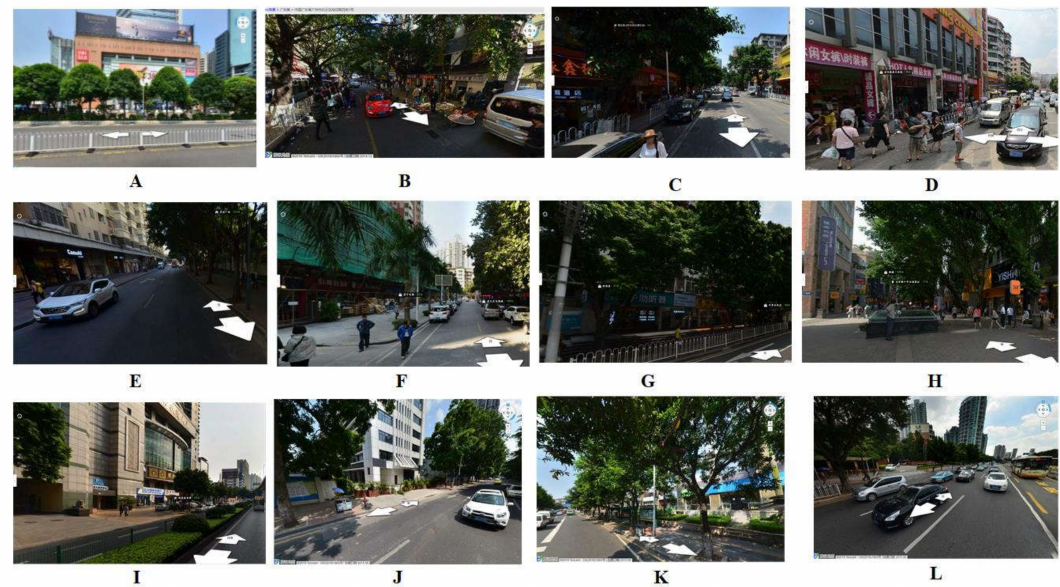
Figure 7. Street view images for each field site. A : close to #101 Tiyuxi road; B : close the middle of Guihua road; C : close to the #32 Shipaidong road; D : close to a cloth whole sale market in Xianliedong road; E : close the middle of Huale road; F : close to the middle of Dashatou Sanma road; G : close to the #53 Zhongshaner road; H : close to the #303 Beijing road; I : close to the #57 Zhongshanyi road; J : close to the #24 Machang road; K : close to the #8 Linhezhong road; L : close to the #191 Zhongshanxi